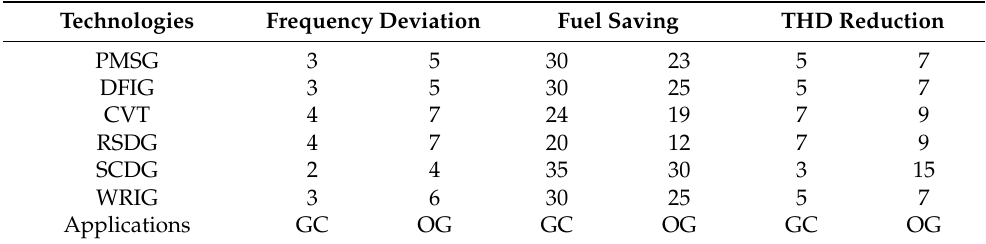
Table 2. Impact of integration of VSDG technology into different